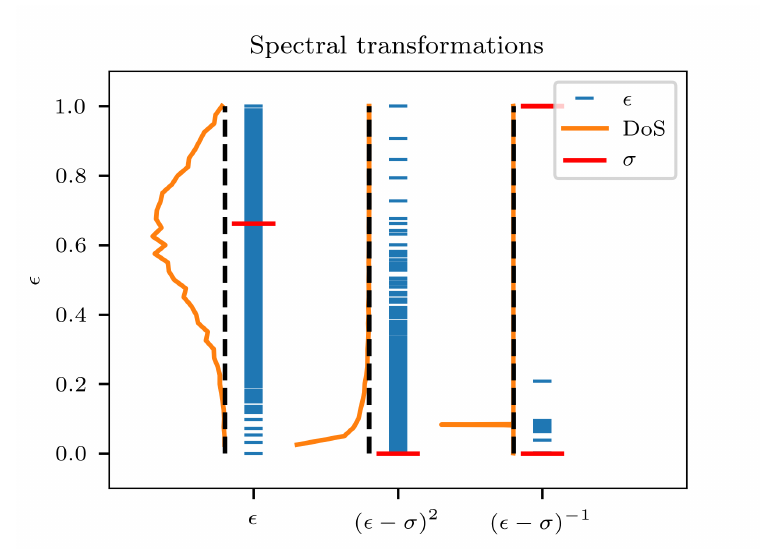
Figure 1: Eigenvalues and densities of states (DoS) for the original spectrum of the clean ( h = 0) chain of length L = 14 in the S spectra, all spectra normalized between 0 and